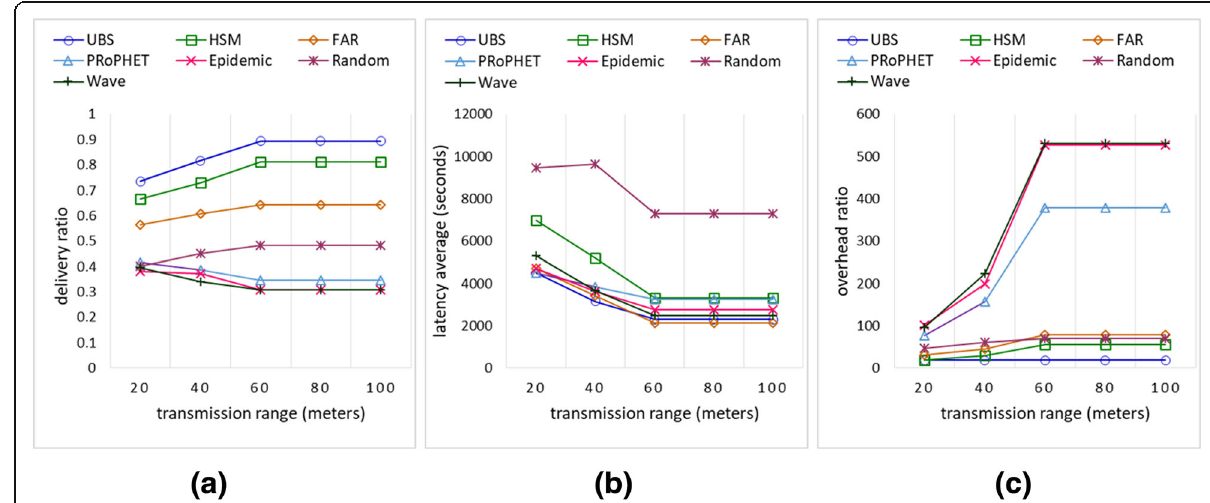
Fig. 11 The performance of schemes by varying range.